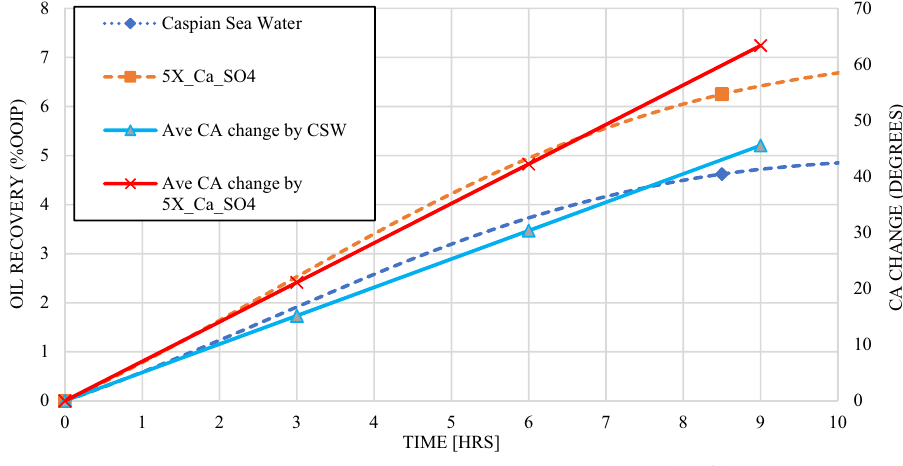
Fig. 12 Combined plot of %OOIP and calculated aver- age CA change versus